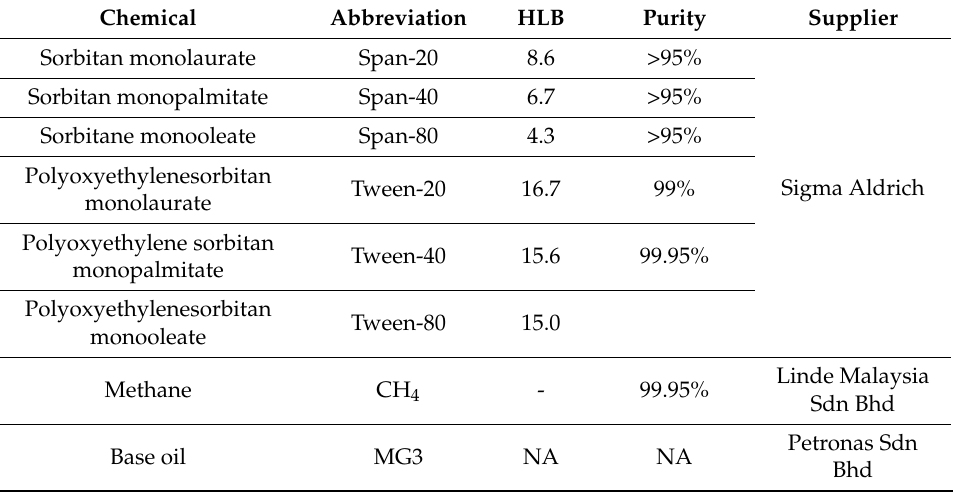
Table 1. The names, abbreviations, properties, and suppliers of the chemicals